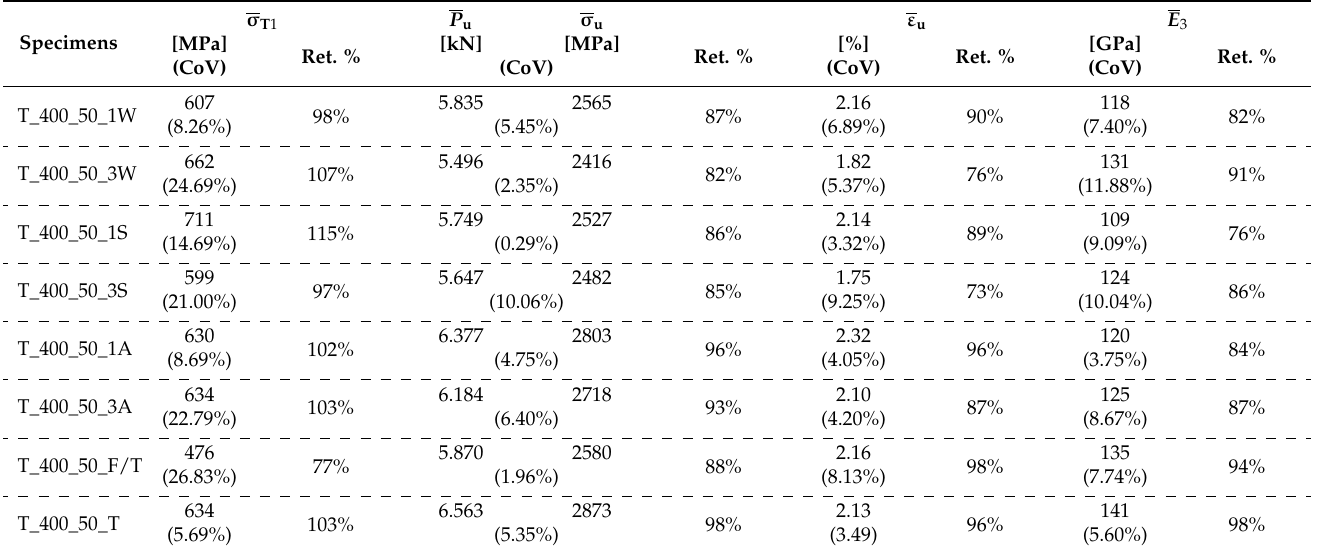
Table 3. Average results of conditioned specimen groups and retained